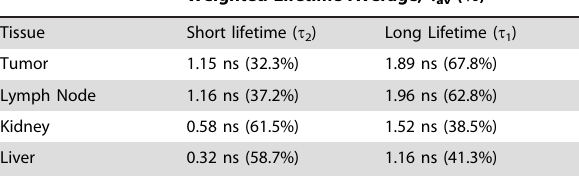
Table 2. Long ( t 1 ) and short ( t 2 ) fluorescence lifetime components and their weighted average value t av (%) measured in ex vivo organs of mice bearing SKOV-3 xenograft tumors after injection with SOR-C27-Cy5.5 derived from a two-exponent